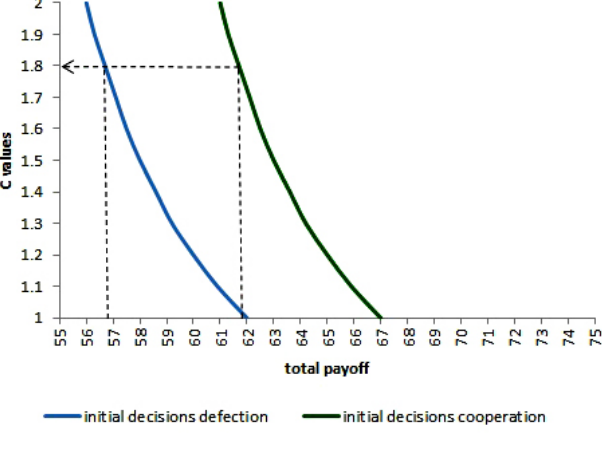
Fig. 10 . C and payoff values in agent-based modeling (ABM) in